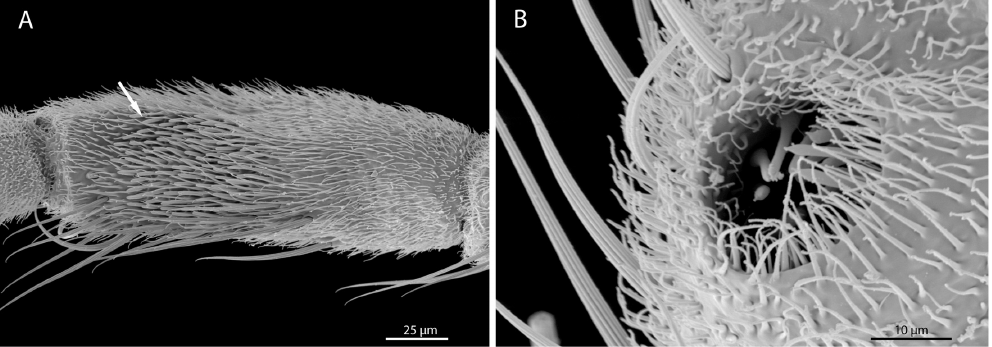
Figure 4 . Sensorial fi eld on maxillary palpomere 3, SEM images. A, Sylvicola fenestralis (Anisopodidae), ventral. B, Edwardsina gracilis (Blephariceridae), ventral.